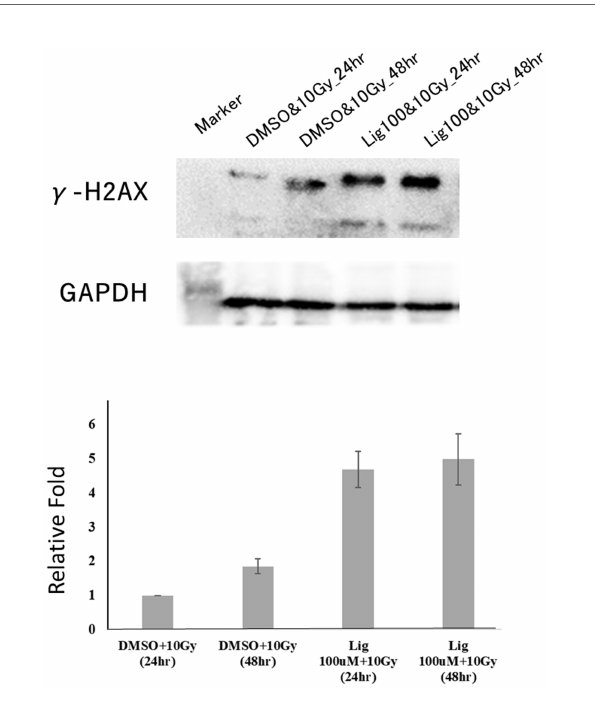
FIGURE 6 | Ligustilide can increase the expression of g -H2AX and enhance the occurrence of DNA damage in oral cancer cells. After treating oral cancer cells with ligustilide (100 m M) for 24 h, the cancer cells received a dose of 10 Gy. The cancer cells treated with ligustilide and 10 Gy produced a large amount of g -H2AX protein after 24 h and its expression even exceeded the control group treated with DMSO and 10 Gy for 48 h. GAPDH is internal control. The blots were representative of three independent experiments. Data were expressed as mean ± SD ( n ≥